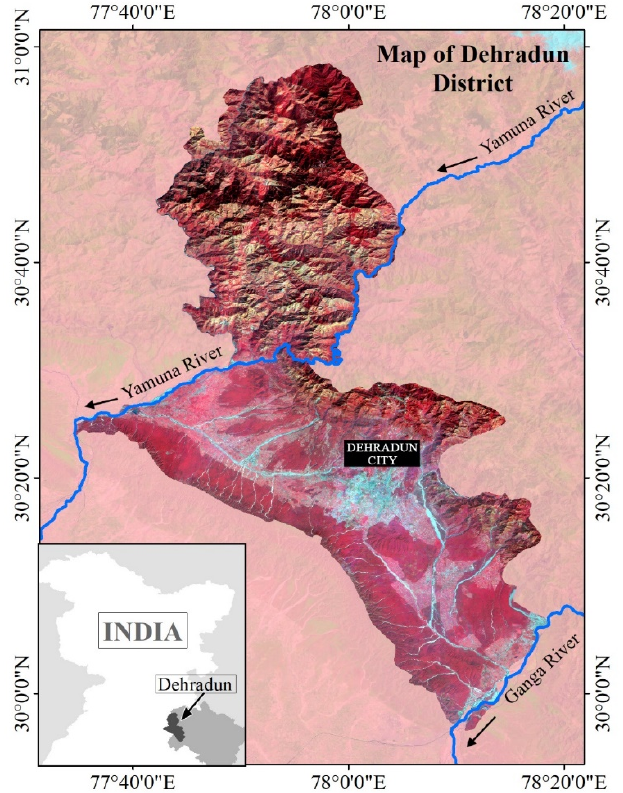
Figure 1. The study area, Dehradun district shown as a false color composite of surface reflectance images (bands 2, 3, and 4 depicted in blue, green, and red colors, respectively) of 2017, where a median composite image is created using all the Landsat-8 Operational Land Image (OLI) images.